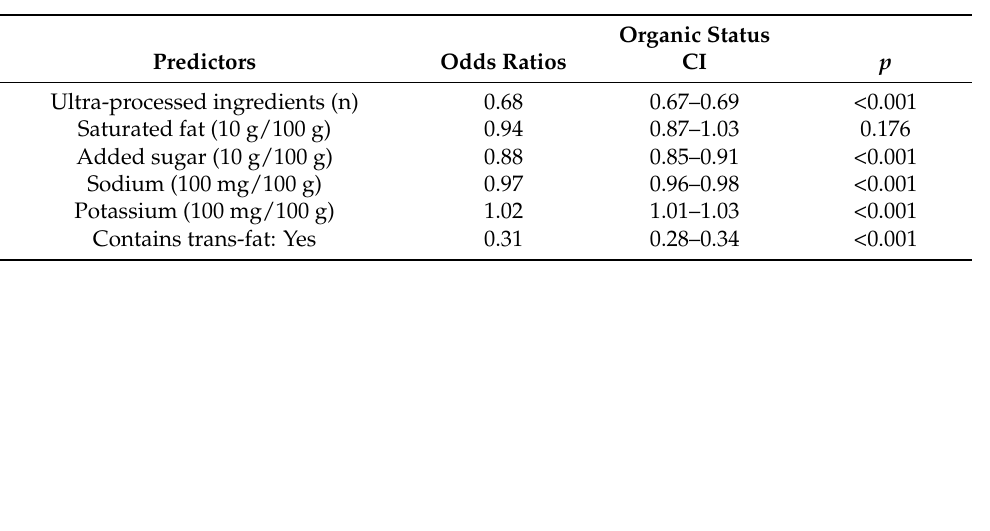
Table 3. Results from mixed logistic regression model of 8240 organic and 72,205 conventional products including the imputed missing nutrient data. This model included parameter “ultra- processed